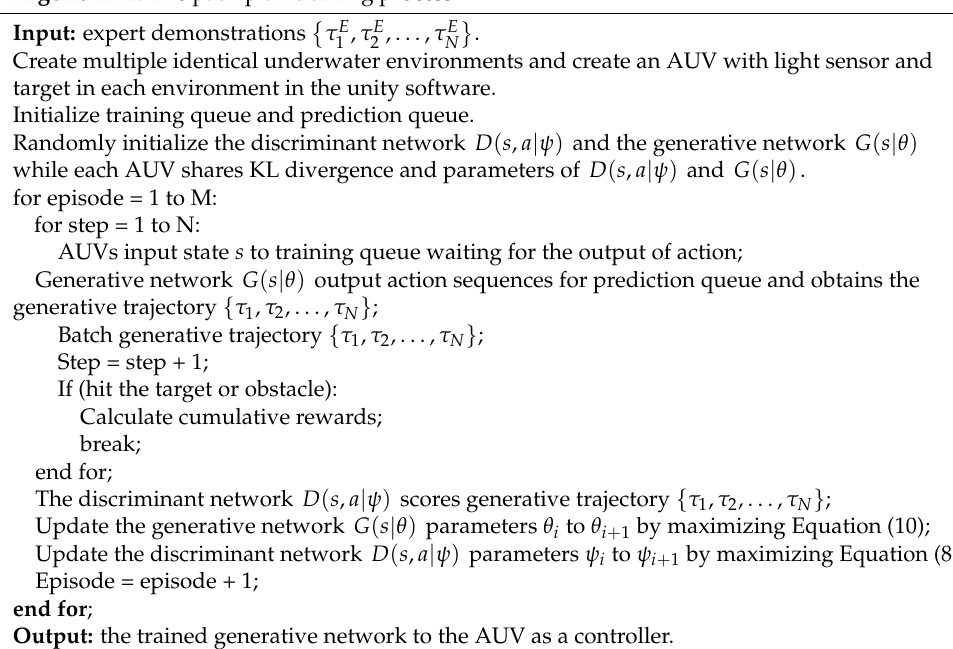
Algorithm 1. The path-plan training